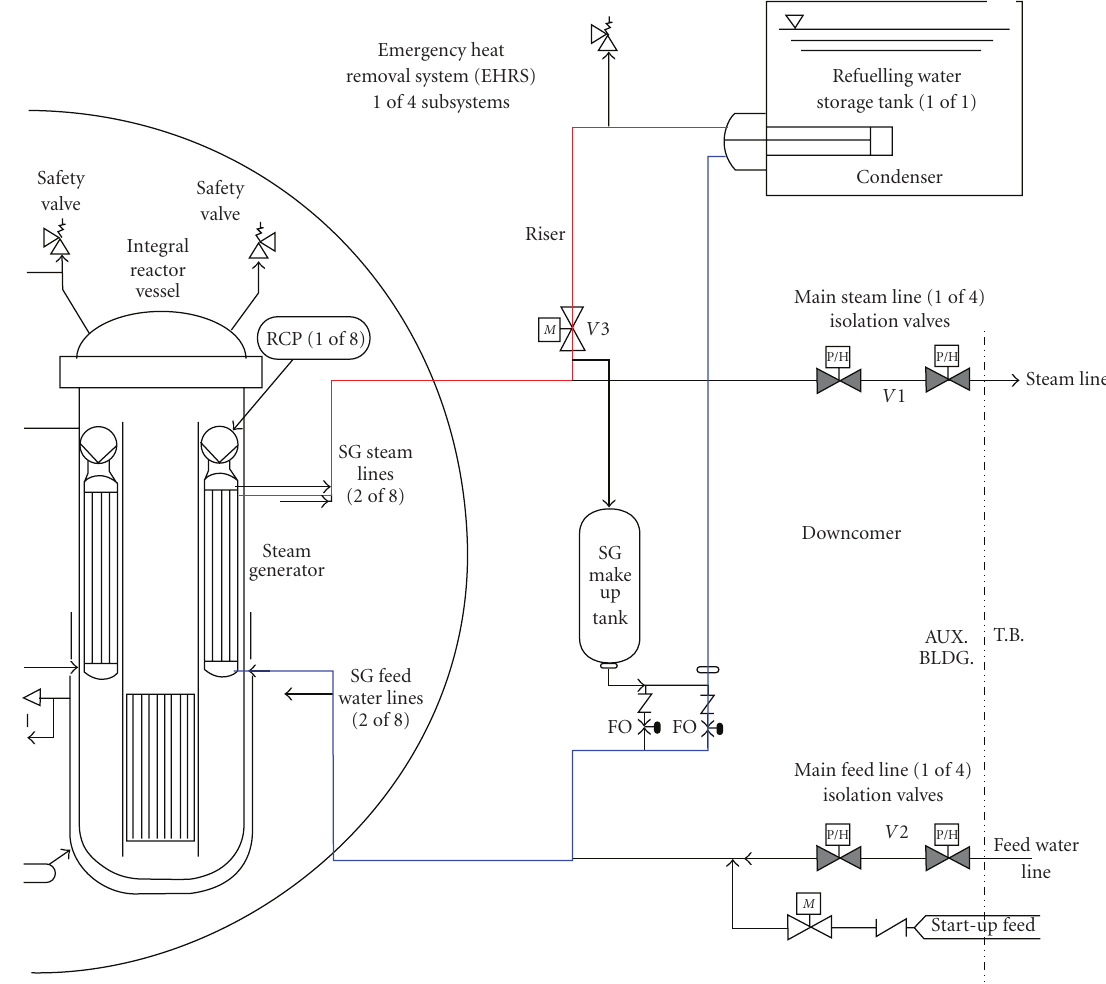
Figure 1: Sketch of IRIS emergency heat removal system